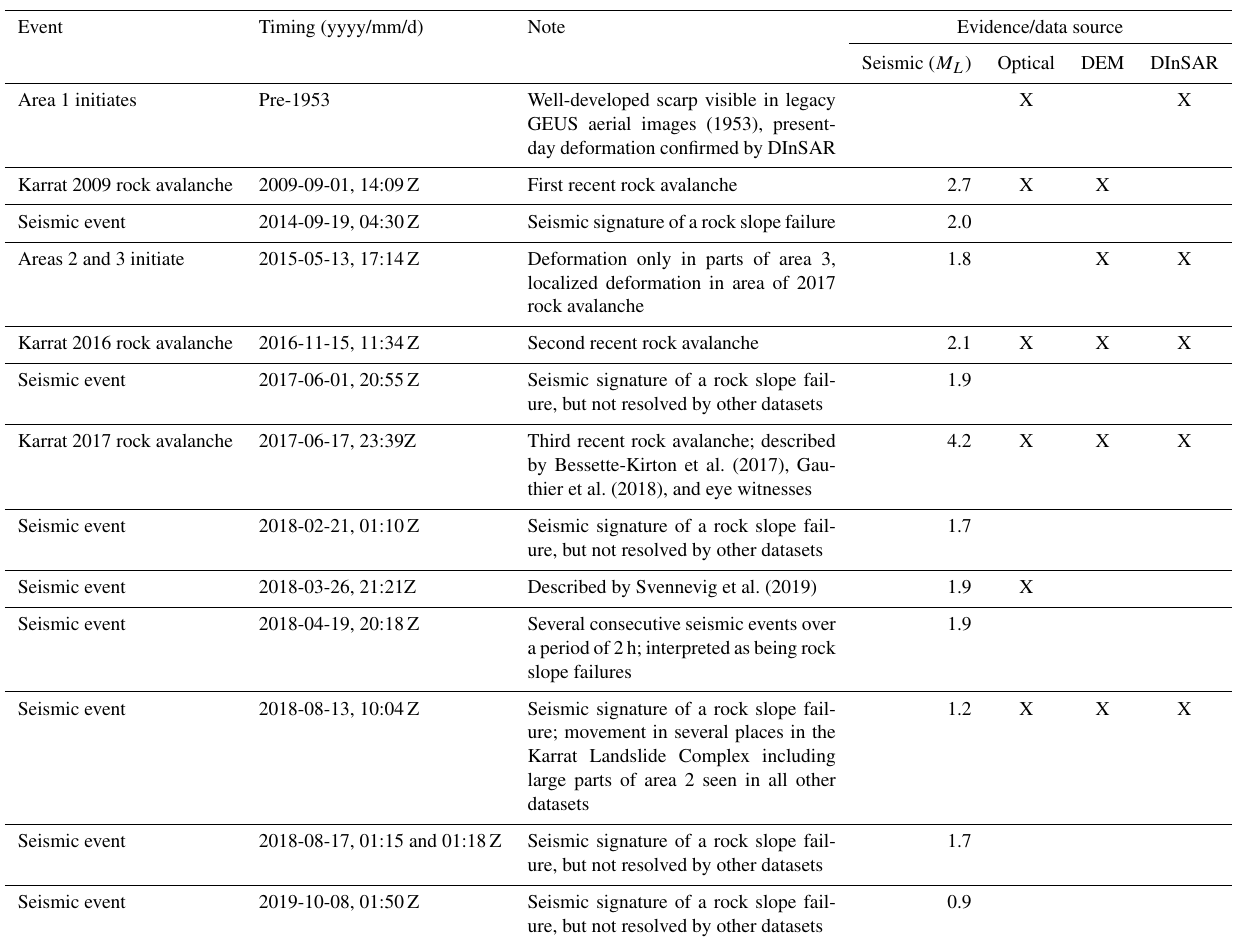
Table 2. Summary of chronological listing of events at the Karrat Landslide Complex.